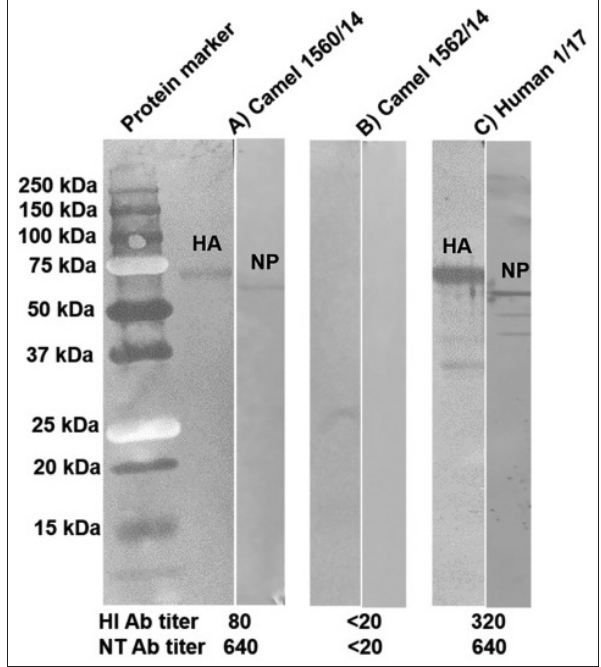
Figure-2: WB assay for the detection of antibody to HA and NP proteins of H1N1pdm09 virus in the camel serum. Recombinant proteins of HA and NP were used as the test antigen and rabbit anti-camel conjugate-HRP was used as the secondary antibody. The rHA (MW=59 kDa) and rNP (MW=53.5 kDa) proteins were detected by antibodies in the camel serum sample ID 1560/14 with HI antibody titer of 80 (A) as well as the convalescent serum from an H1N1pdm09 patient (C) but neither HA nor NP protein was detected by the camel serum sample ID 1562/14 with HI antibody titer <20